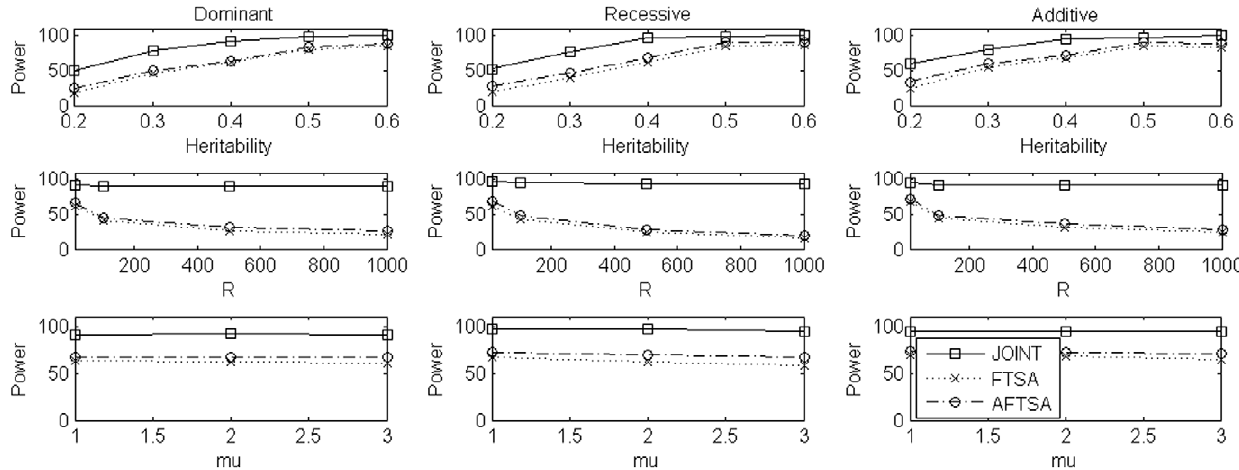
Figure 3. Power comparison under simulation set 3 when sample size is 600 trios. In the first row, we compare power of the three methods for different values of heritability under the three disease models while m =2 and the number of markers selected at the first stage is 10. In the second row, we compare power of the three methods for different numbers of markers selected at the first stage under the three disease models while m =2 and heritability is 0.05. In the third row, we compare power of the three methods for different values of m under the three disease models while heritability is 0.05 and the number of markers selected at the first stage is 10. In each case, we use 800 genomic markers to control for population stratification in the admixture screening